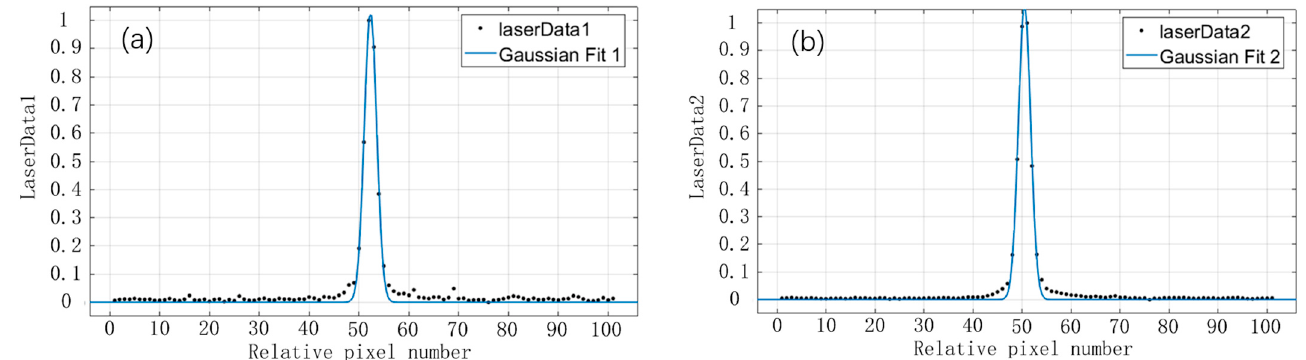
Figure 27. The position of the laser on the image plane of the detector before and after the field test: ( a ) Location before field test: 52.32; ( b ) Location after field test: 50.49.